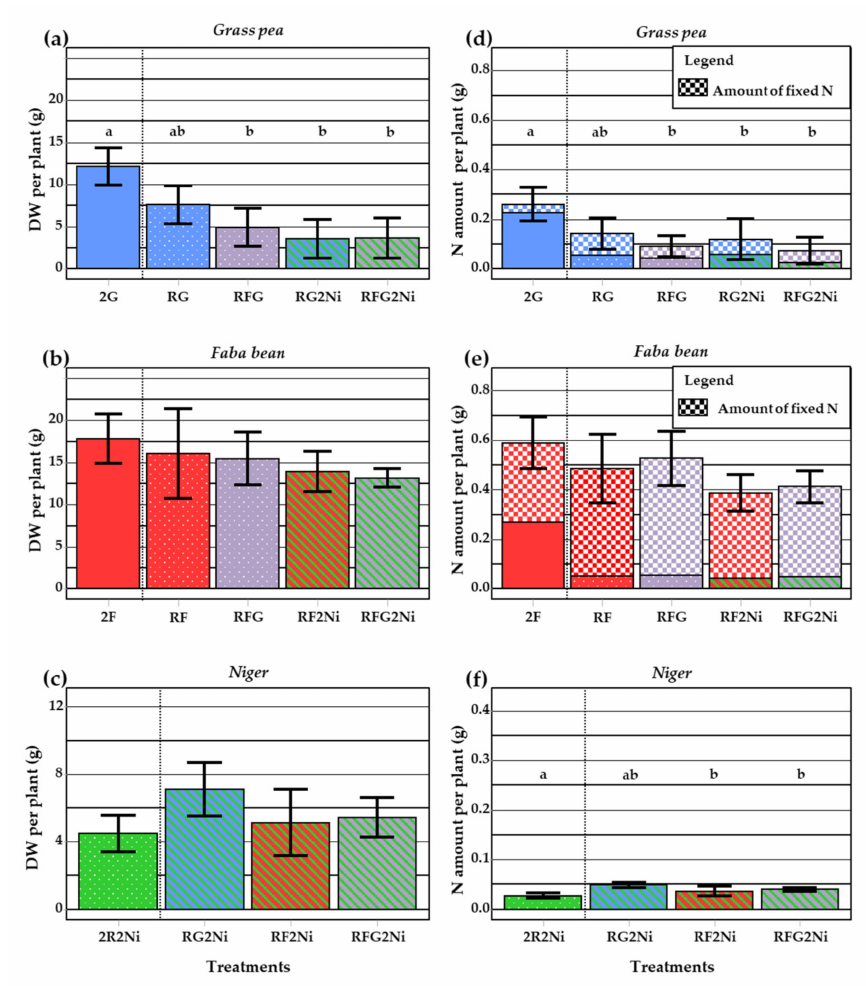
Figure 3. Above ground dry weight ( a – c ), and N ( d – f ) in service plants (g · plant − 1 ). R: OSR ( Brassica napus L. cv Avatar), F: Faba bean ( Vicia faba L. cv Fanfare), G: Grass pea ( Lathyrus sativus L. cv Merkur) and Ni: Niger ( Guizotia abyssinica (L.f.) Cass.). Means of four replicates. Error bars are SDs. When one-way ANOVA had p < 0.05, the different letters a and b indicate significant differences across treatments (Tukey HSD). Table 2. Percentage of nitrogen derived from biological fixation (%Ndfa) in legumes service plants. 2F/2G FG Grass